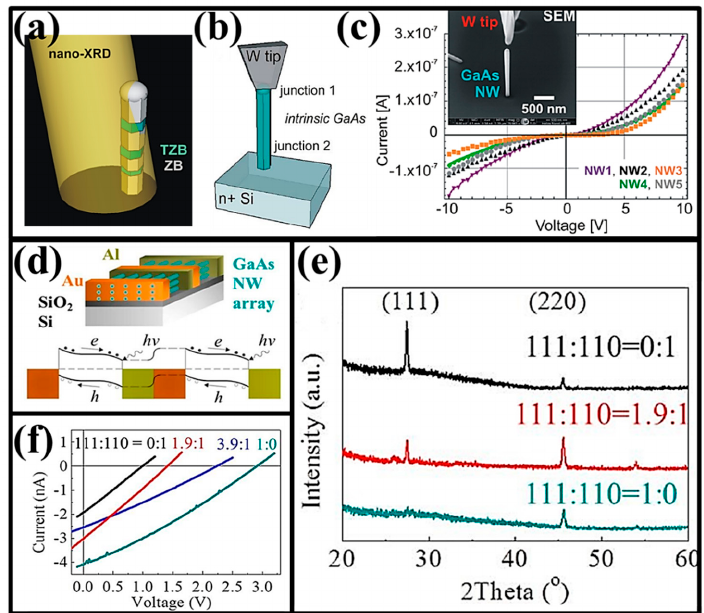
Figure 7. Correlation of structure and properties of GaAs NWs. ( a – c ) In situ measurement of the as-grown individual GaAs NW within a dual-beam SEM system. The I–V characteristics of selected NWs were measured through a tungsten tip brought into contact with the top of the NW, whereas the structural information was revealed by n-XRD on the same NW using focused synchrotron radiation. ( d – f ) Crystal orientation controlled PV properties of multilayer GaAs NW arrays. ( d ) Schematic illustration of the PV device structure and the corresponding energy band diagram. ( e ) XRD patterns collected of the three-layer GaAs NW parallel arrays. The growth directions of NWs were evaluated by XRD before the fabrication of corresponding parallel NW array based Schottky PV devices. ( f ) The PV performance fabricated with different mixing ratios of <111>- and <110>-oriented NWs. Adapted with permission from [131,132].